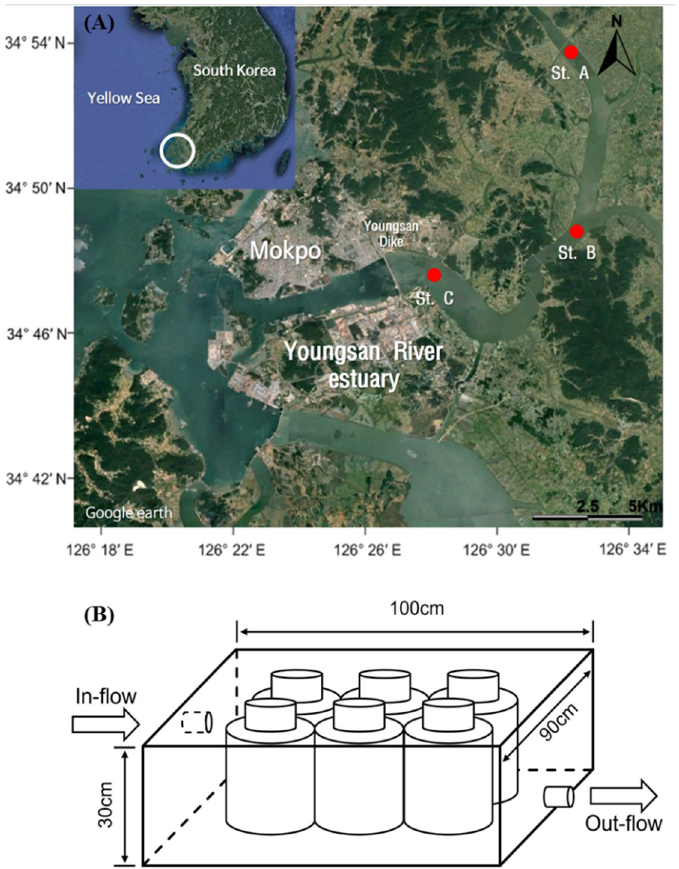
Figure 1. Sampling stations in the freshwater zone of the Yeongsan River estuary ( A ) and incubation bath ( B ) used in the mesocosm experiments to simulate the natural environments by circulating estuarine water inside the bath using an electric pump. Two baths were interconnected for the experiments.